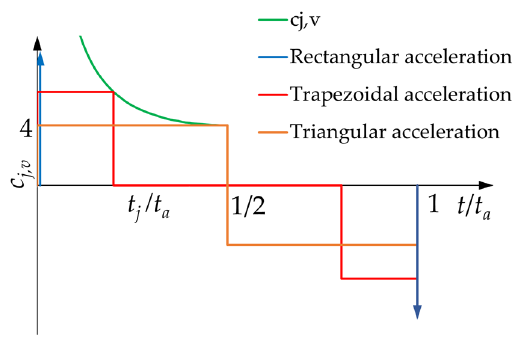
(cid:95)  t j and different dimensionless jerk c versus t and different dimensionless jerk profiles. j,v j